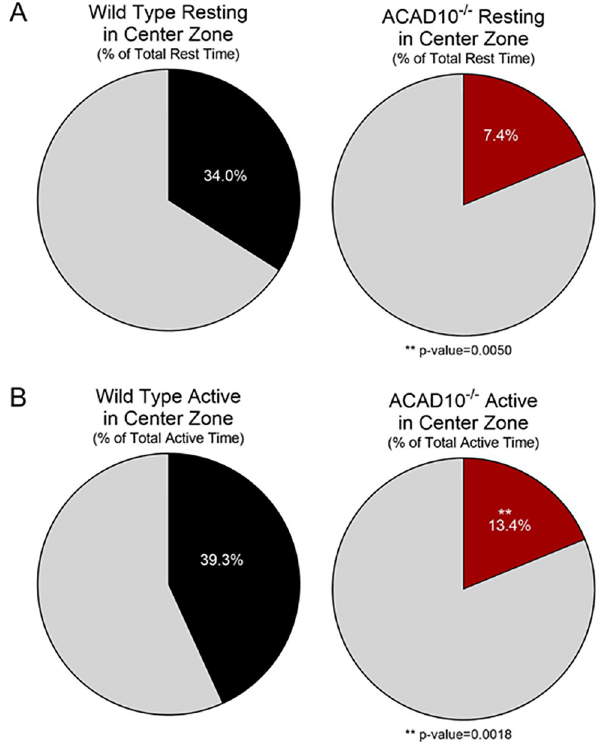
Fig 5. Temporal distribution of activities in the open field test by wildtype and Acad10- deficient mice. (A-B) Group averages of the percent of total rest time or percent of total active time spent in the center (colored segments) versus the surround (grey segments) of the the open field arena for wild-type mice (black) and Acad10- deficient (red) mice. Of the total amount of time mice rested (A) or were active (i.e., engaged in locomotion, rearing, or movements while stationary; B), the percent of time mice did so in the center of the test arena was statistically significantly lower for Acad10- deficient mice compared to wild-type mice of the same background (unpaired Student’s T-test with Welch’s correction, p-value <